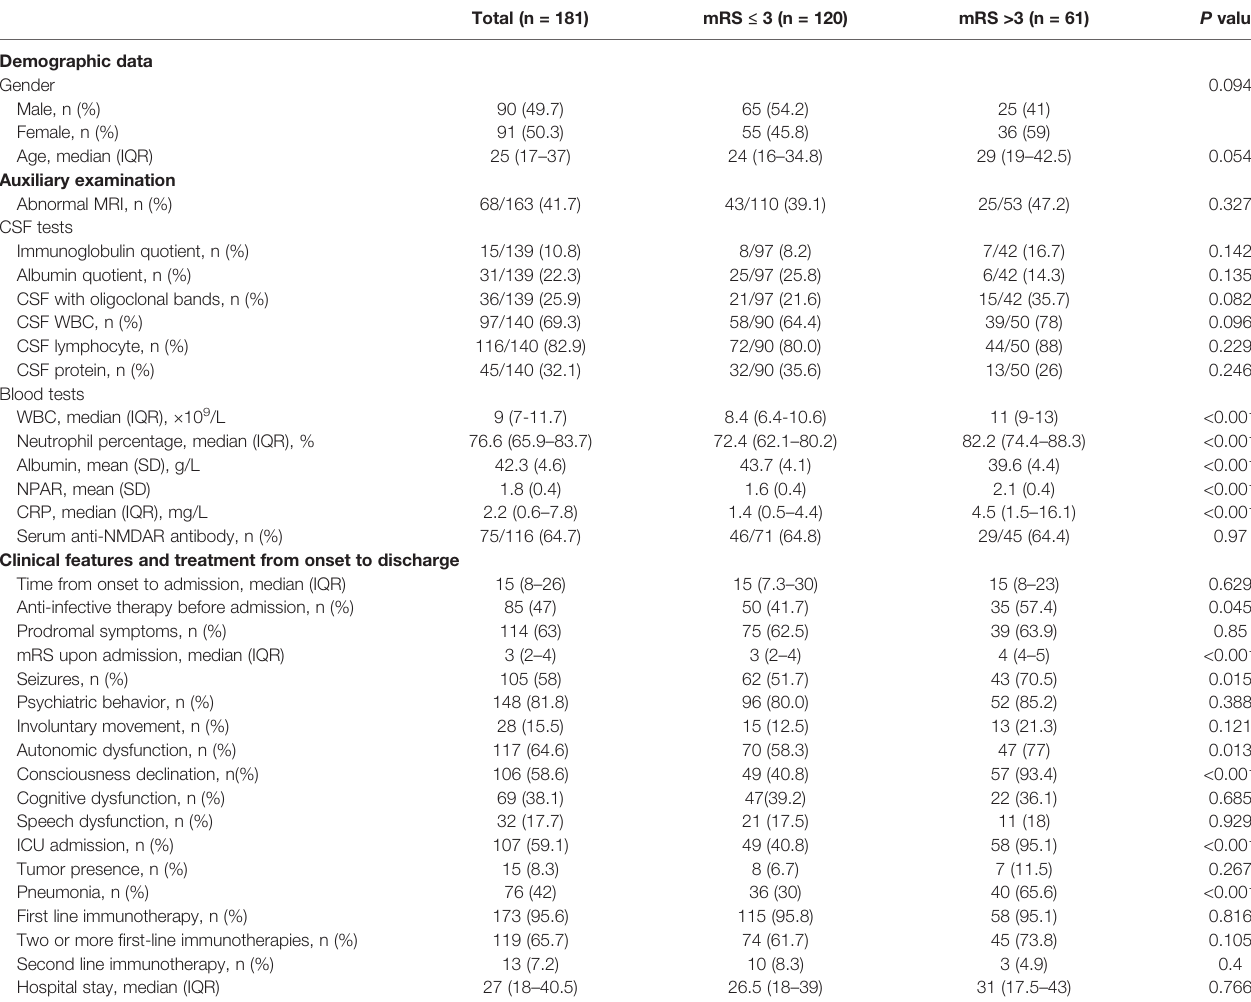
TABLE 2 | Comparison of clinical data of anti-MNDAR encephalitis with different severity at discharge (short-term prognosis). Total (n = 181) mRS ≤ 3 (n = 120) mRS >3 (n =